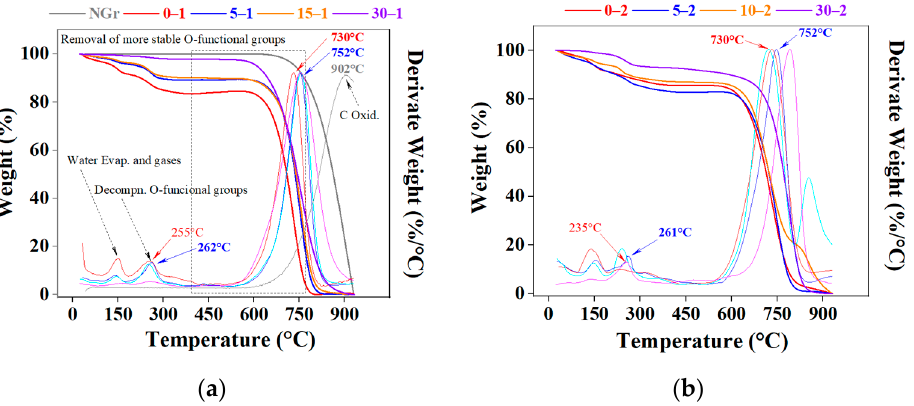
Figure 6. Thermogravimetric (weight loss) and derivate curves of raw graphite and intercalated materials: ( a ) 30% (series 1) and ( b ) 50% H 2 O 2 (series 2). materials: ( a ) 30% (series 1) and ( b ) 50% H 2 O 2 (series